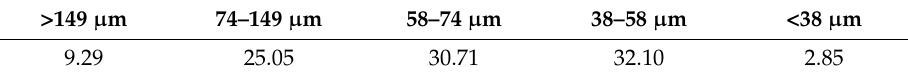
Table 2. Particle size distribution of the sample of Bayan Obo tailings (wt. %).